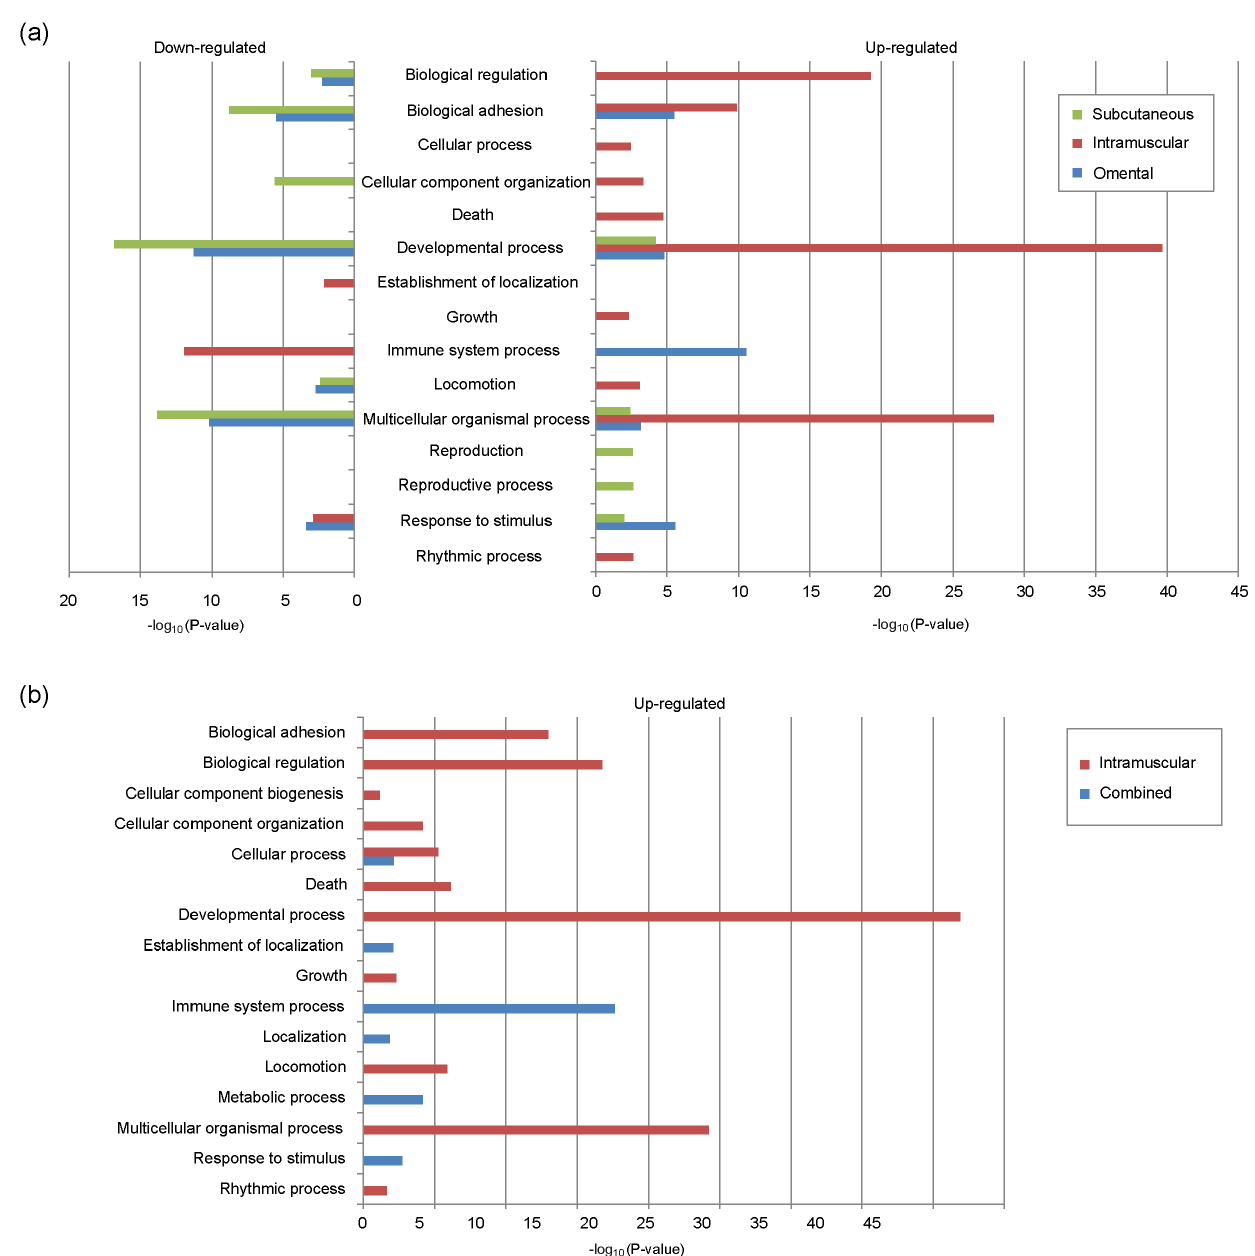
Figure 3. Biological process GO terms analysis of depot specifically regulated DEGs (a) and DEGs identified from the comparison between I and C (b).